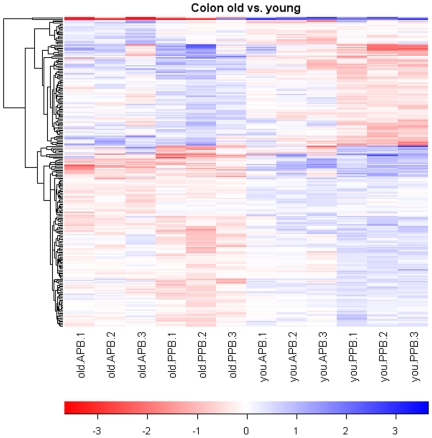
Heatmap of senior vs. young adult dog pairwise comparisons.Values are the GCRMA-processed probe set value (Log2 scale) minus the mean value for that probe set across all arrays. The dendrogram was created by hierarchical cluster analysis.